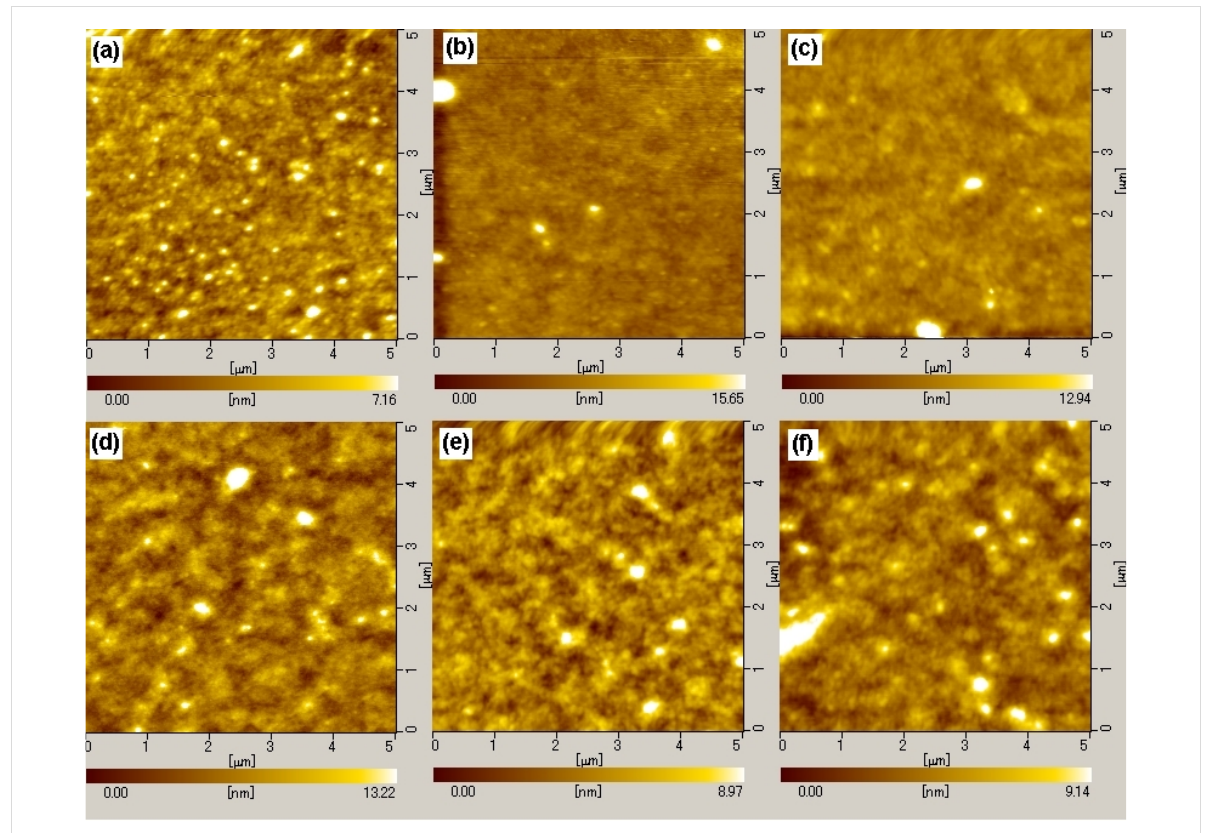
Figure 5: The AFM images of the P3HT: 1a - and P3HT:PCBM-blended films annealed at different temperatures. (A) P3HT: 1a -blended film annealed at 100 °C for 30 min, Ra:0.8161 nm, P-V: 15.02 nm: RMS: 1.110. (B) P3HT: 1a -blended film annealed at 130 °C for 30 min Ra: 0.6775 nm, P-V: 17.51 nm, RMS: 0.9067 nm. (C) P3HT: 1a -blended film annealed at 140 °C for 30 min, Ra: 0.8884 nm, P-V: 69.73 nm, RMS: 1.734 nm. (D) P3HT:PCBM- blended film annealed at 100 °C for 30 min, Ra: 1.531 nm, P-V: 35.72 nm, RMS: 2.159 nm. (E) P3HT:PCBM-blended film annealed at 130 °C for 30 min, Ra: 1.083 nm, P-V: 15.34 nm, RMS: 1.418 nm. (F) P3HT:PCBM-blended film annealed at 140 °C for 30 min, Ra: 1.135 nm, P-V: 13.47 nm, RMS: 1.573.